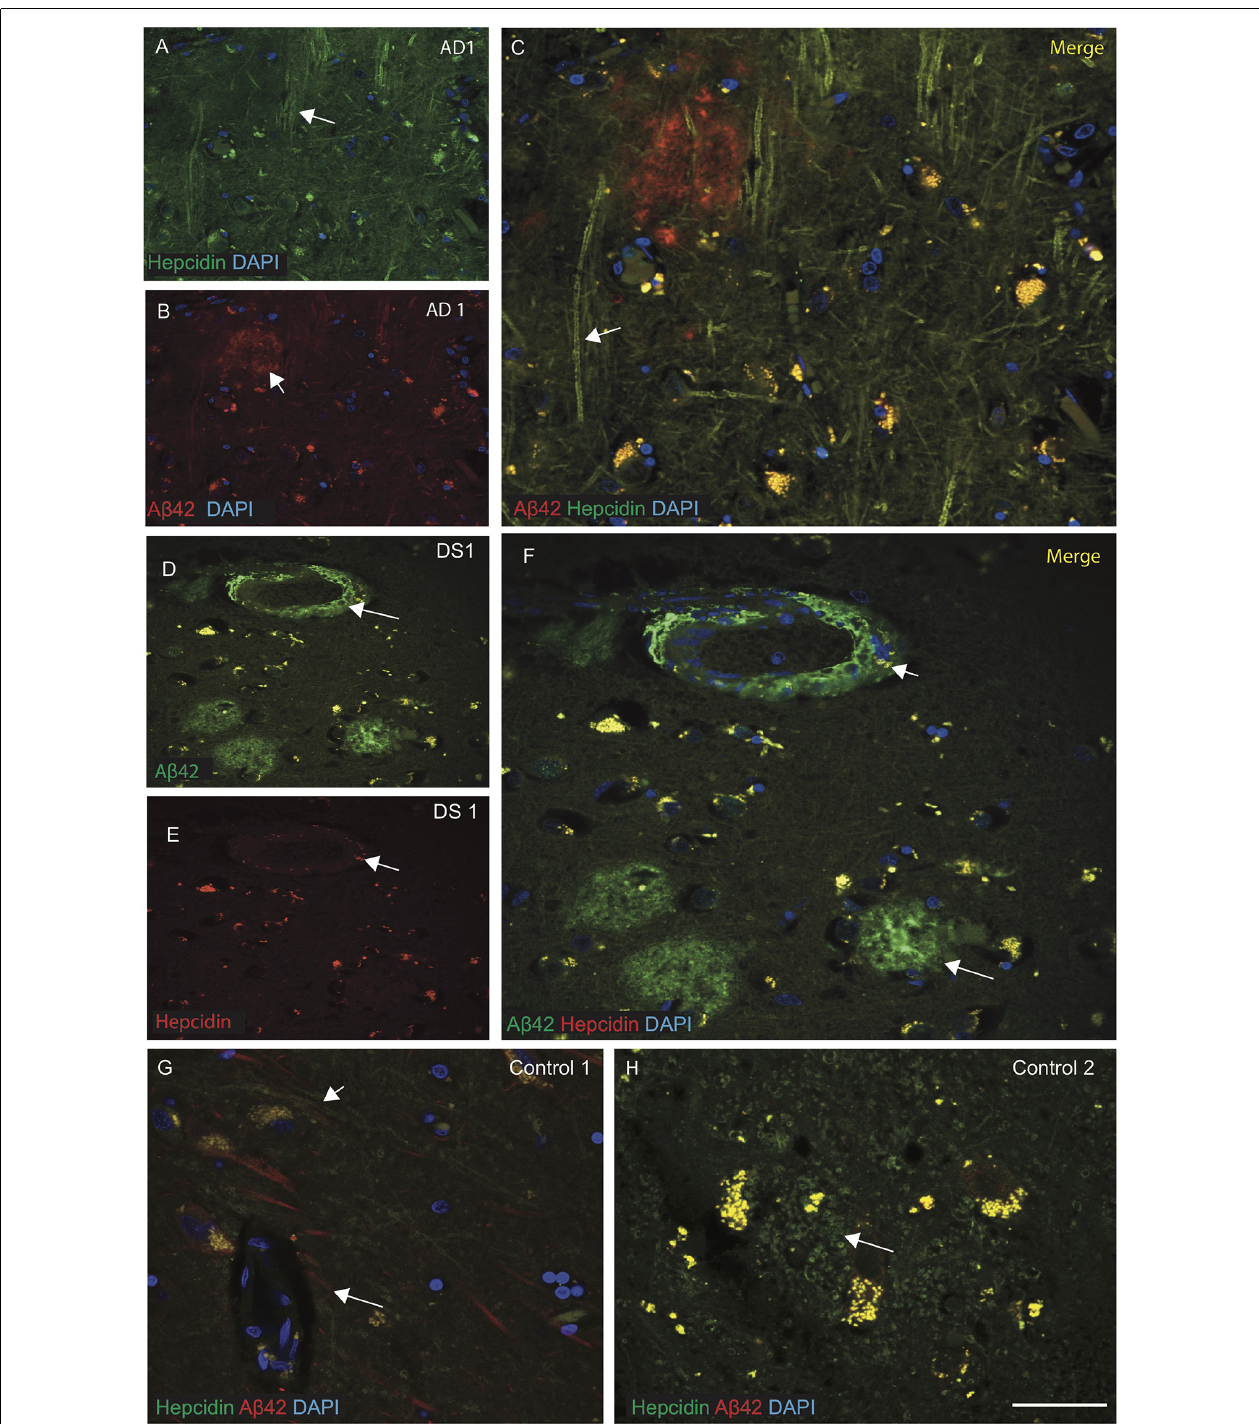
FIGURE 2 | Hepcidin protein accumulates around the senile plaques in AD and DS brains. AD and DS brain sections from the SFG were labeled with double immunofluorescence using anti-A β 42, anti-hepcidin and counterstained with 4 (cid:48) 6-diamidino-2-phenylindole (DAPI) for nuclei (blue) and imaged with confocal microscopy. In AD brain, hepcidin staining was visible in the neuropil and fibrillary structures close to the A β 42 positive senile plaques (SP) (A–C) , white arrows highlighting the selected areas with hepcidin in neuropil and A β 42 staining in the SP). In DS brain, abundant A β 42 positive cotton wool appearance of SP, close to the blood vessels were observed, while very limited hepcidin positive glial cells were present in the periphery of plaques (D–F) . In contrast, control brains showed co-localization of A β 42 and hepcidin near the blood vessels (G) , while hepcidin predominated in the astrocytes located in the periphery of the glial cells (H) . Scale bar: (A–H) = 25 µ